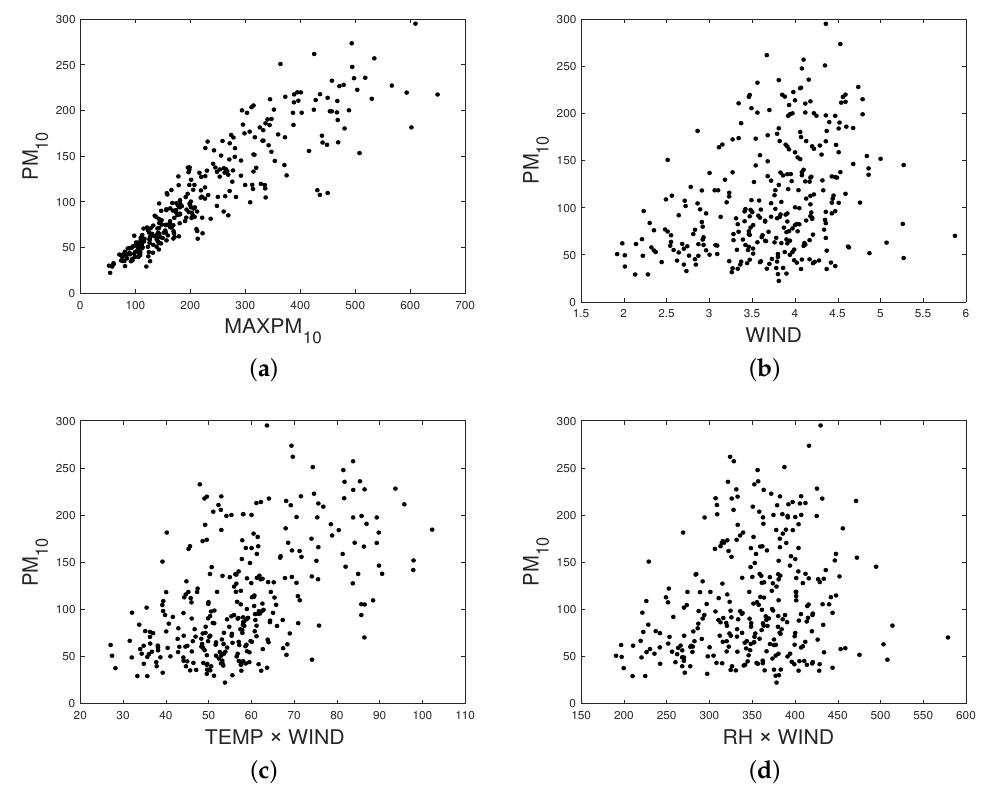
Figure 10. Scatter plots for ( a ) PM 10 v/s MAXPM 10 , ( b ) PM 10 v/s WIND, ( c ) PM 10 v/s TEMP × WIND, and ( d ) PM 10 v/s RH ×